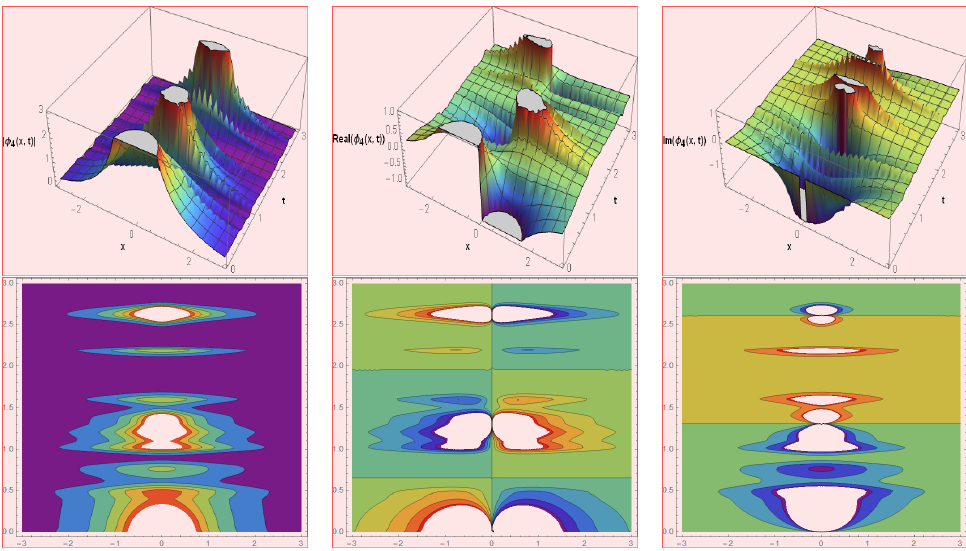
Figure 3. The absolute, real, and imaginary behavior in the shape of 3D and their corresponding contour plots are dispatched for φ 4 ( x , t ) .